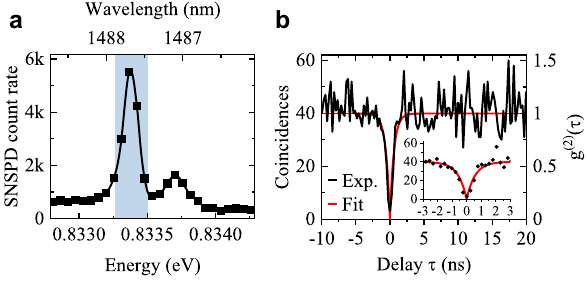
Figure 6: QD single-photon emission. (a) The μ PL spectrum for the CX line recorded on superconducting nanowire single-photon detectors with (b) CX autocorrelation histogram. Shaded area in (a) marks the monochromator